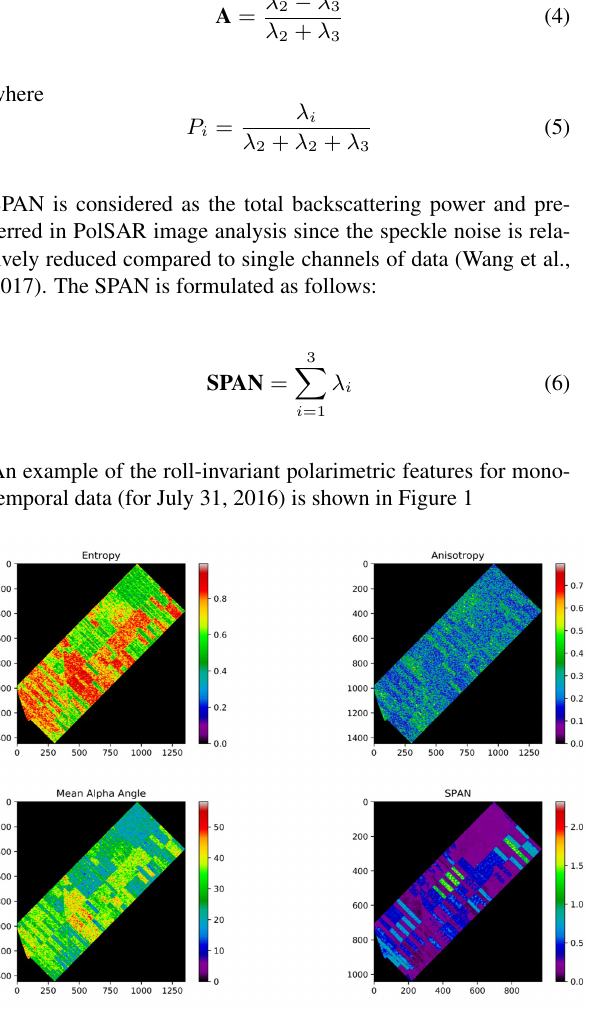
Figure 1. Roll-invariant polarimetric features